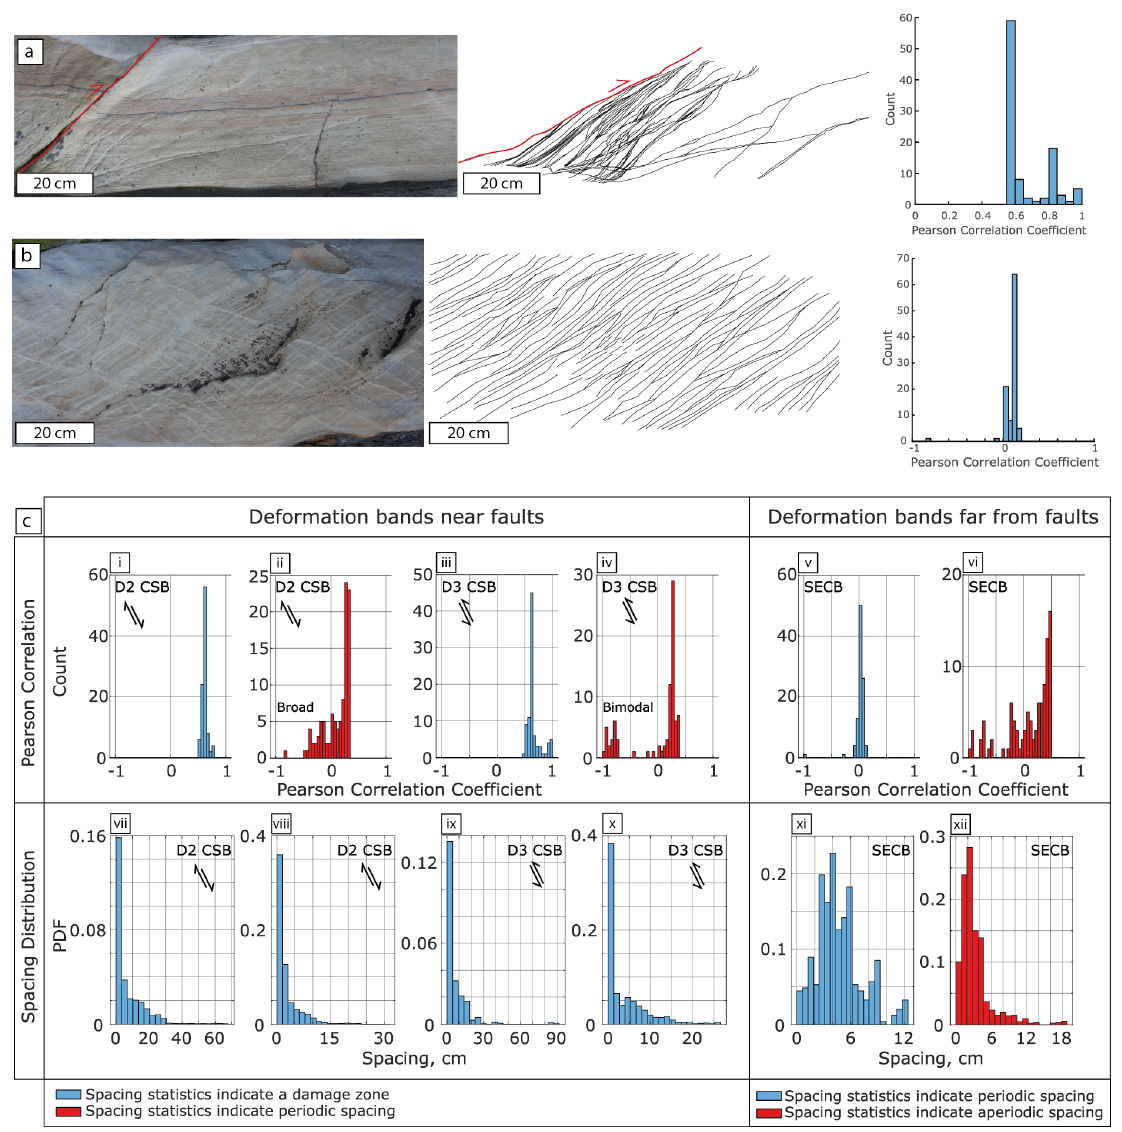
Figure 16. (a) Spacing analysis of CSBs hosted in the damage zone of a small reverse fault with up to 20cm displacement. The image documents the upper end of the fault, approaching the tip. (b) Spacing analysis of dominantly SECBs with rare CSBs not associated with the damage zone of faults. The bands show a near-constant spacing with a median spacing of 1.3 cm. A total of 100 scan lines were taken for panels (a) and (b) . The Pearson correlation coefficient values for panel (a) are mostly > 0.5, which is indicative of a positive correlation between the spacing of bands and the distance from the fault plane, as is expected in a damage zone. The Pearson correlation coefficient values for panel (b) are close to zero, which is indicative of an constant spacing. (c) Spacing statistics for selected outcrops to highlight the variation in deformation band distribution across the field site. The figure has been separated into bands that were analysed adjacent to normal faults and reverse faults, where a decay of spacing away from the fault plane is expected, and those that were analysed away from fault planes where no correlation between spacing and distance is expected. Two examples of each have been chosen to represent possible end-member datasets. Panels (i) to (vi) show distributions of Pearson correlation values for each analysed scan line for the outcrops. CSBs are primarily associated with faults and are expected to show a positive correlation (Pearson > 0.5). SECBs, with some conjugate CSB sets, were measured > 2 m from faults and should not show a correlation between spacing and distance resulting in a Pearson value close to zero. Panels (i) , (iii) , and (v) show examples that match these predictions. Panels (ii) , (iv) , and (vi) are examples that contradict these predictions. Panels (vii) to (xii) show the spacing frequency distributions for different outcrops. Band spacing associated with faults is expected to show a positive skew. All bands associated with faults show a positive skew. However, variation can be seen with large ranges and a non-smooth curve. Bands not associated with faults are expected to show a Gaussian distribution, representing a regular spacing with noise (Fig. 10b): panel (xi) shows this, whereas panel (xii) is characterised by a positive skew, as would be expected for a fault damage zone. Data for all analysed outcrops can be observed in Sect.